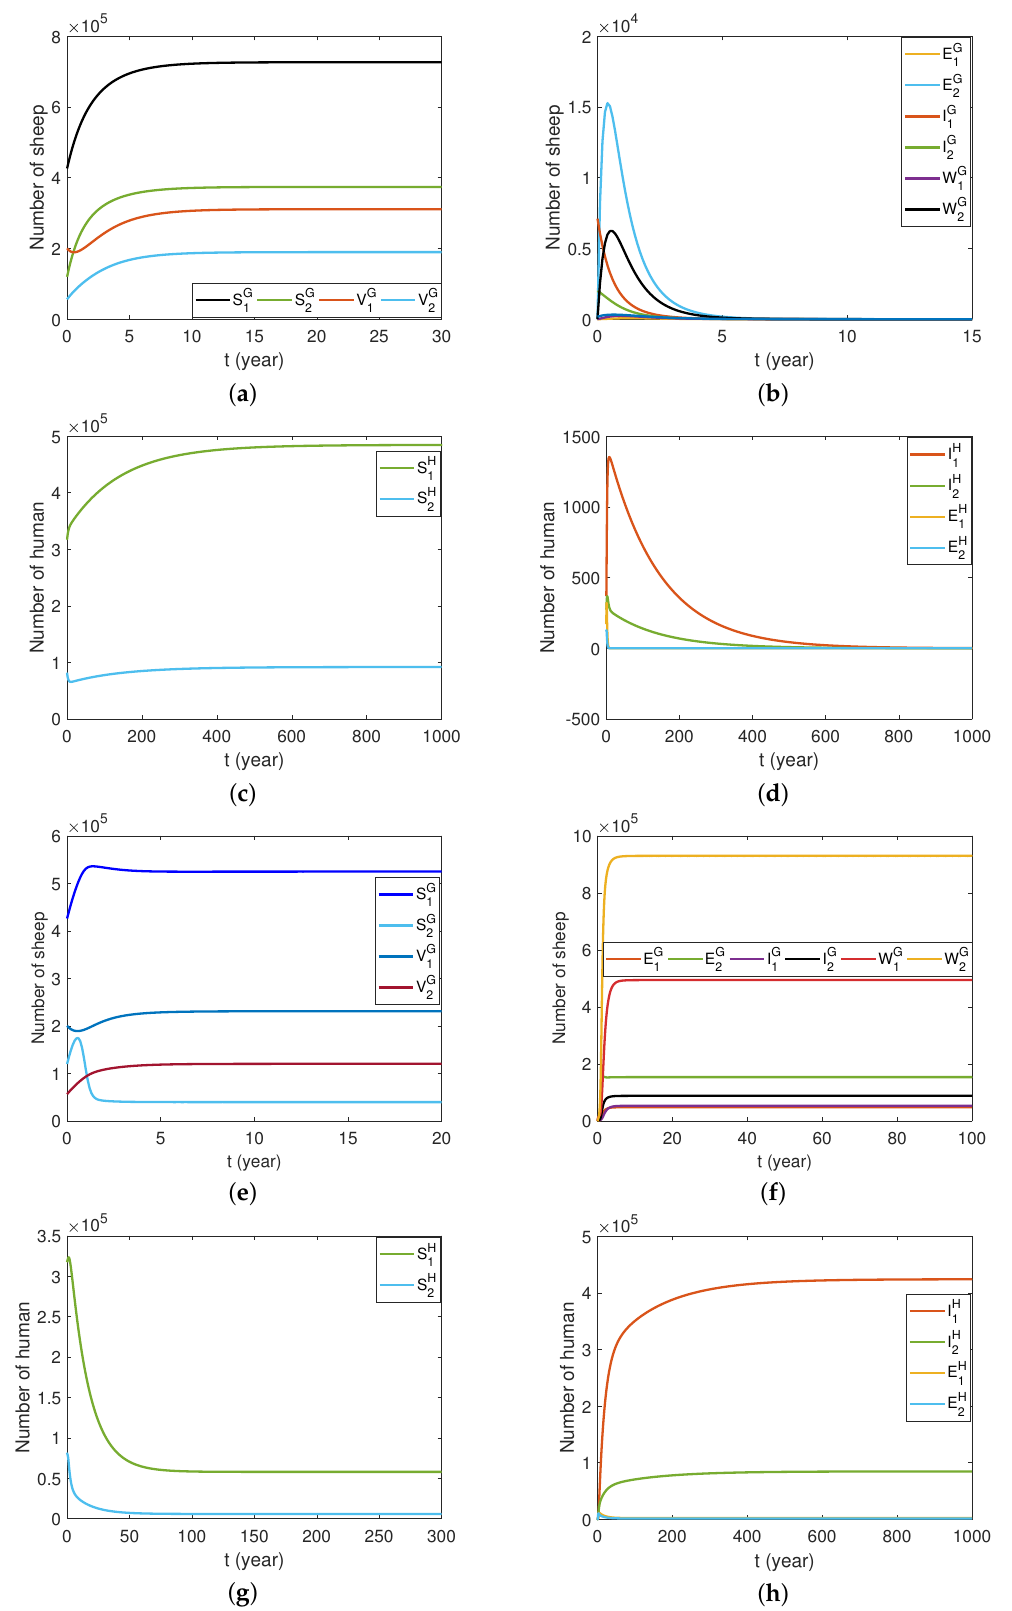
Figure 8. ( a – d ) represent the global stability of equilibrium P 0 with R 0 = 0.2146; ( e – h ) represent the global stability of equilibrium P ∗ with R 0 =